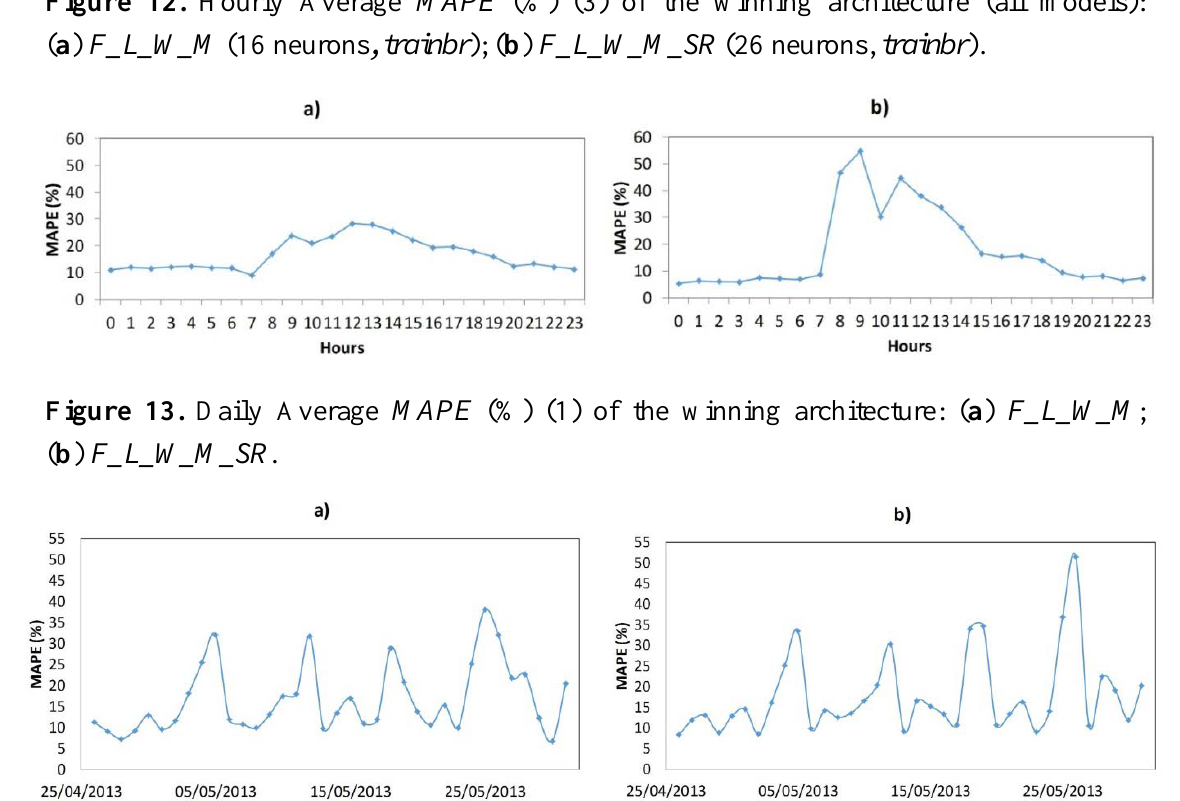
Figure 12. Hourly Average MAPE (%) (3) of the winning architecture (all models):